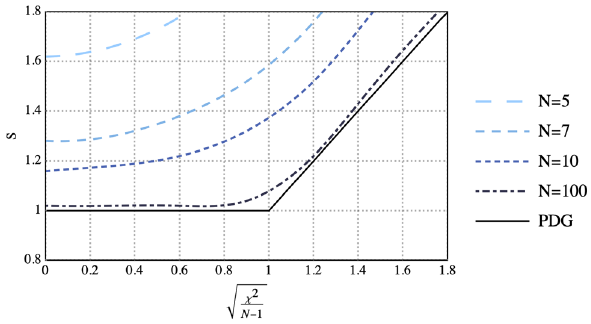
Fig. 3 Scale factor versus the square root of the reduced χ 2 . We employed α =